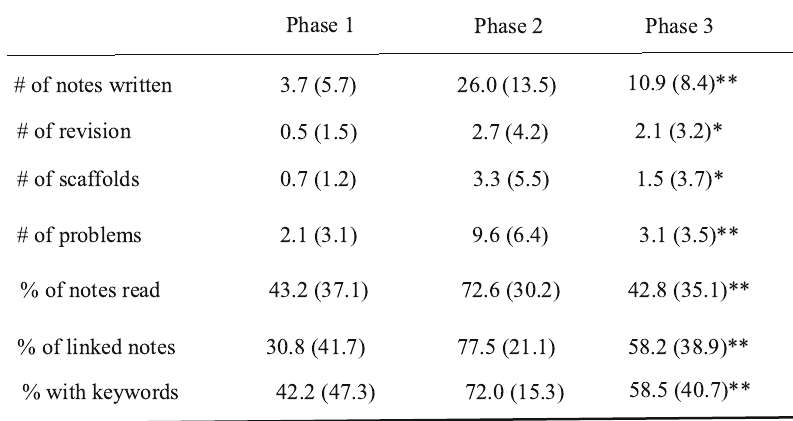
Participation and Collaboration in Knowledge Forum Over Time